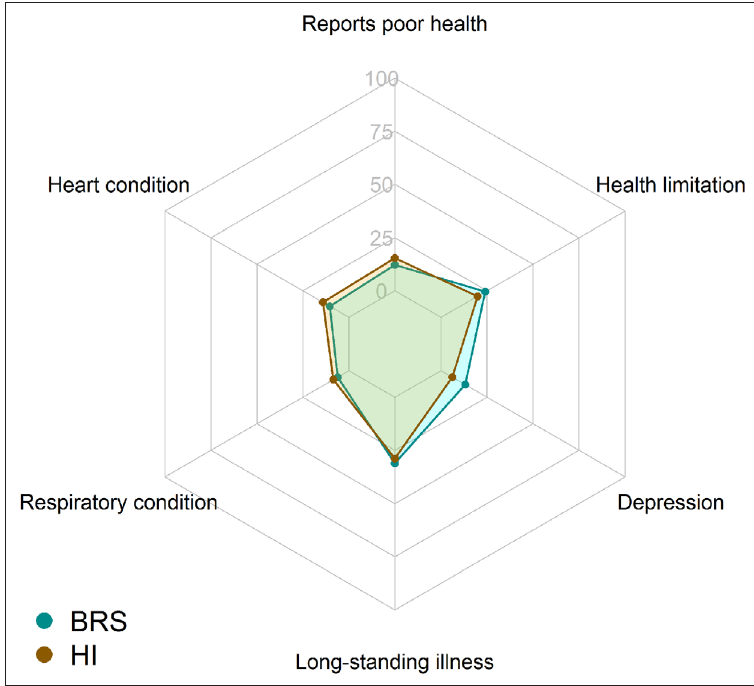
Figure 4: Health and well-being characteristics of biodiversity recorders compared with those of adult population in Ireland using Healthy Ireland Survey (HI).